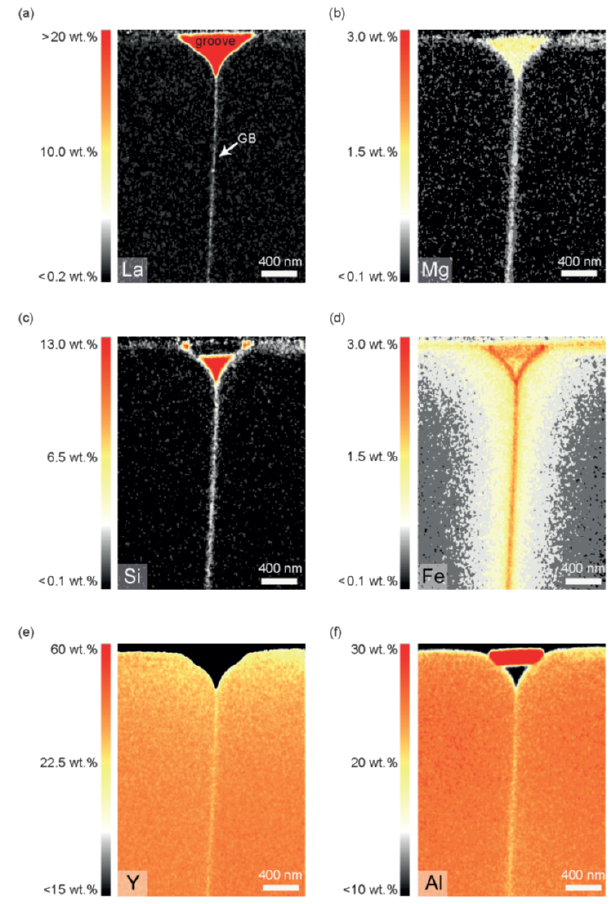
Figure 6. 2D STEM EDX element distribution maps of sample TH_9_2 (1005). The maps are false-color maps, the EDS signals have been quantified using ESPRIT with a quantification method as given in Sect. 3.2. Red indicates high concentrations and black indicates low concentrations of the elements as